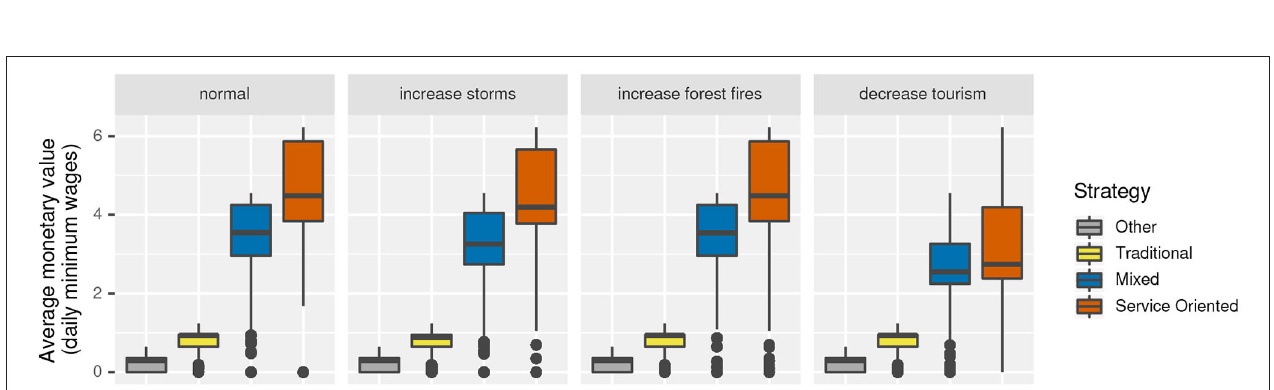
FIGURE 8 | Aggregate average monetary value for different strategies under different disturbance scenarios. The four scenarios shown are: a scenario with normal level of all disturbances, a scenario with an increase in the storms and hurricane occurrence probability, a scenario with an increase in the probability of occurrence of forest fires and a scenario with a decrease in the probability of the flow of tourists. Boxplots represent the yearly average monetary value of different strategies (in colors) for 30 simulations, each ran over a 50 years period.